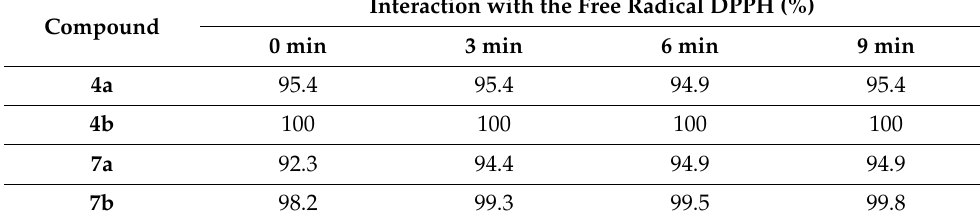
Table 3. In vitro % values for DPPH scavenging activity of the most potent compounds in relation to time. Interaction with the Free Radical DPPH (%) Compound 0 min 3 min 6 min 9 min 4a 95.4 95.4